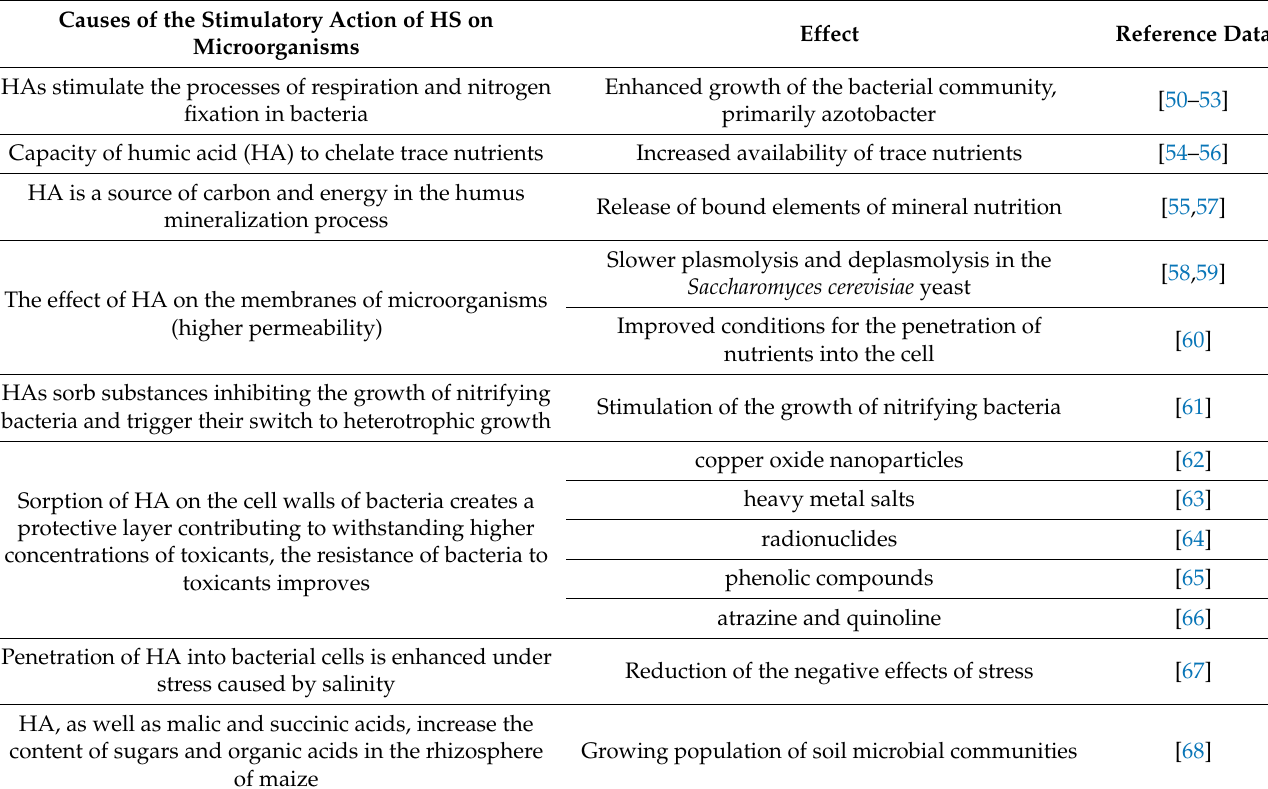
Table 1. Stimulatory action of humic substances (HS) on soil